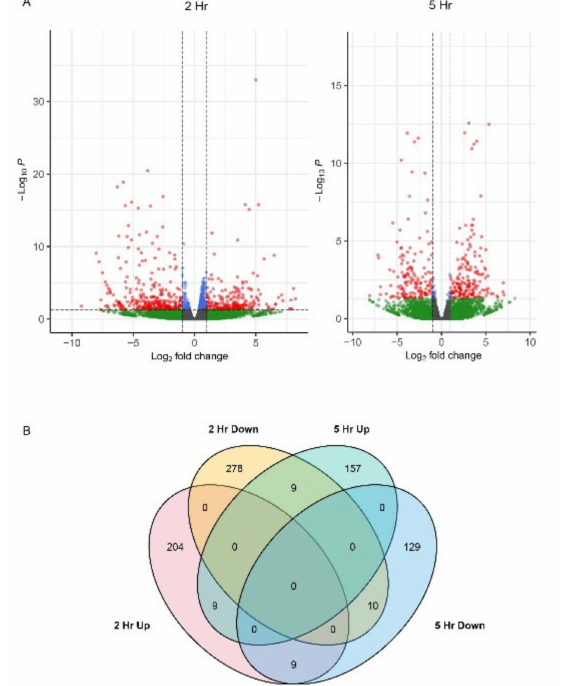
Figure 1. Numbers of differentially expressed genes (DEGs). ( A ) In the volcano plots, the red dots represent the DEGs with the log2FC threshold of ± 1.0 ( p < 0.05). Gray, green, and blue indicate genes that are not significantly altered in expression at Log 2FC 1.0 cutoff. ( B ) A Venn diagram highlighting unique and common DEGs in TM-treated leaves at 2 and 5